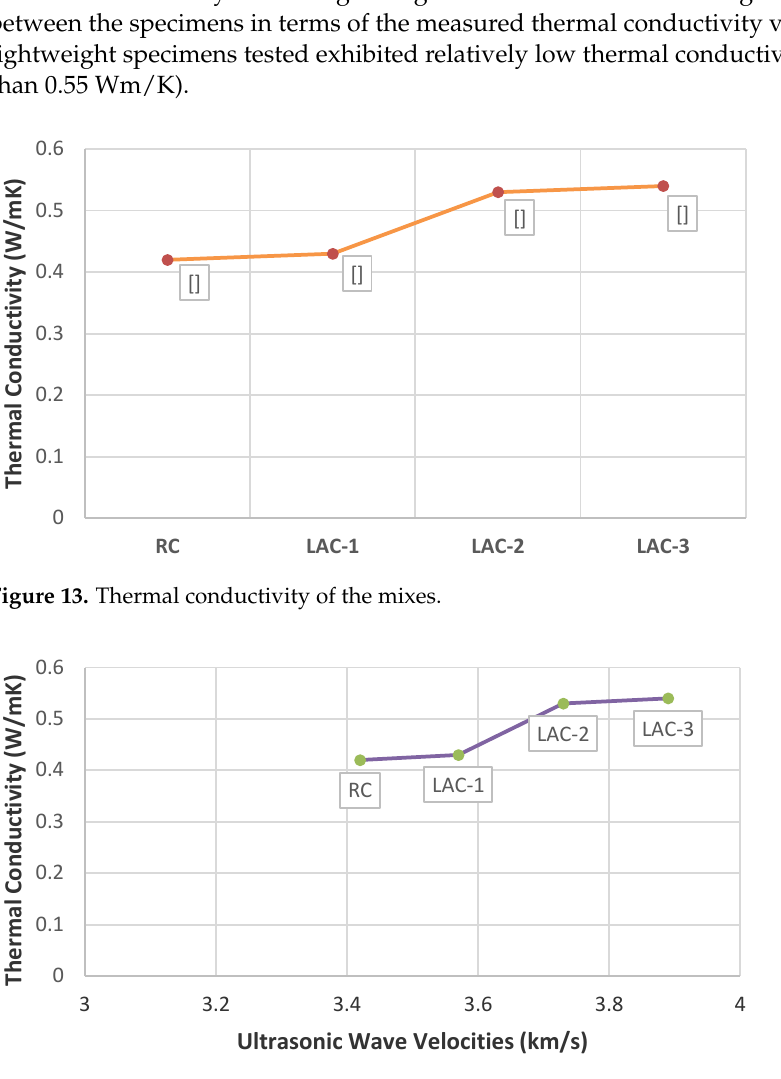
Figure 14. The thermal conductivity vs. the ultrasonic velocities of the mixes.